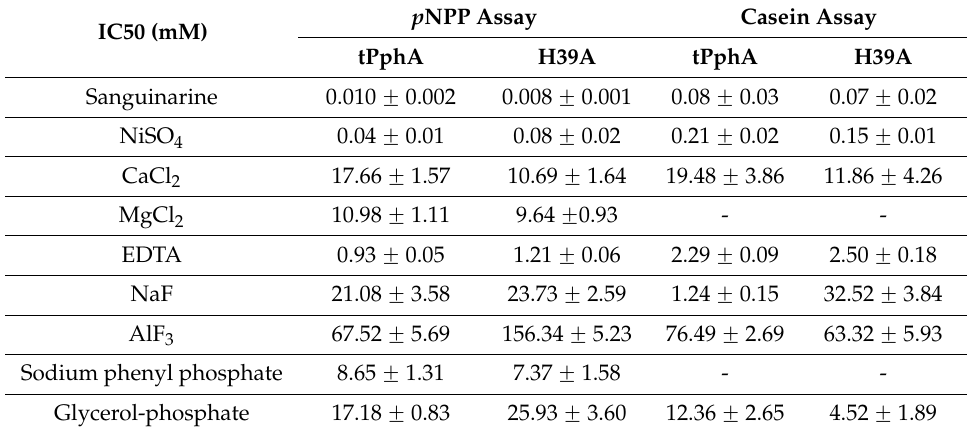
Figure 2. IC50s of sanguinarine on wild ‐ type tPphA with regard to the dephosphorylation of p NPP and casein. The IC50s of other chemicals on wild ‐ type tPphA and H39A were measured in triplicate. The values are listed in Table 4. Table 4. IC50s of nine compounds on tPphA with regard to the dephosphorylation of p NPP and casein.